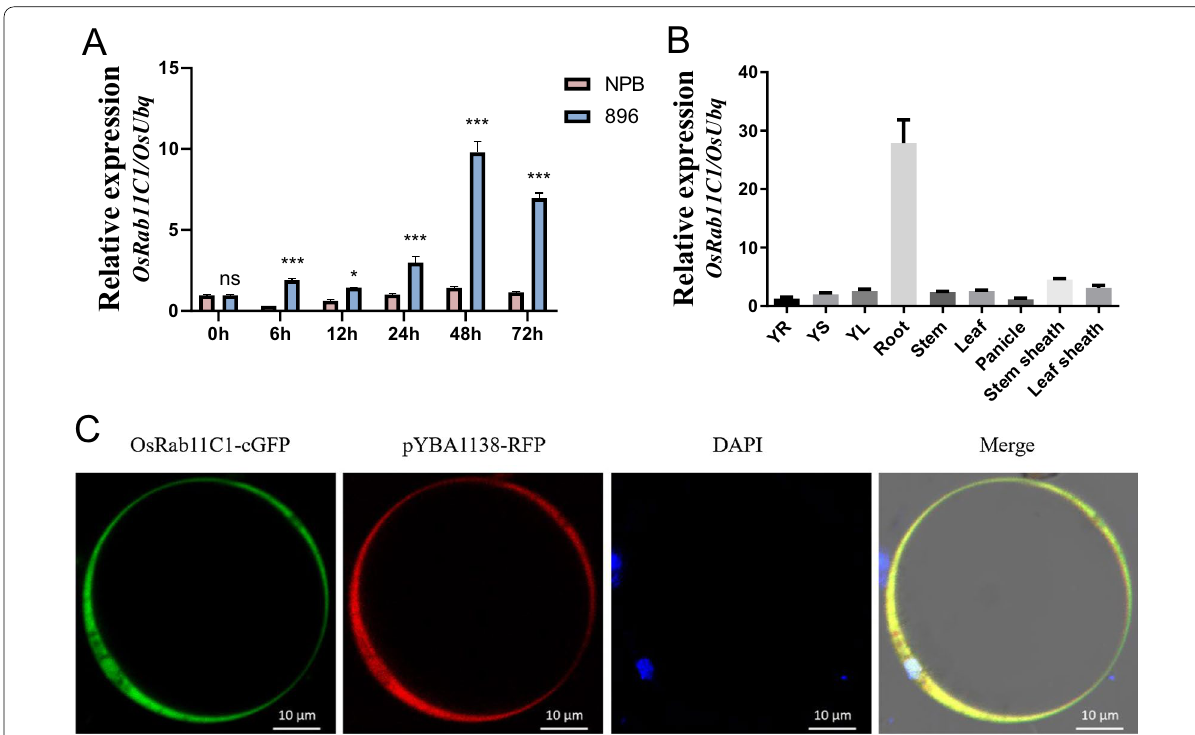
Fig. 3 Expression analysis and subcellular localisation of OsRab11C1. A Relative expression levels of OsRab11C1 in Nipponbare (NPB) and the extremely sensitive cultivar 896 after cold treatment at 4 °C. Pink bars show expression levels of OsRab11C1 in Nipponbare and blue bars are expression levels in 896. The y‑axis represents relative gene expression levels. “ns, * and ***” indicate no significant differences, significant differences ( p 0.05), and highly significant differences ( p 0.001), respectively. B Relative expression levels of OsRab11C1 in different rice tissues. The x‑axis = = represents different rice tissues. YR, young roots; YS, young stems; YL, young leaves. C Subcellular localisation of OsRab11C1 in rice protoplasts. pYBA1138‑RFP was used as a whole‑cell marker. DAPI (4 ′ ,6‑diamidino‑2‑phenylindole) was used to stain